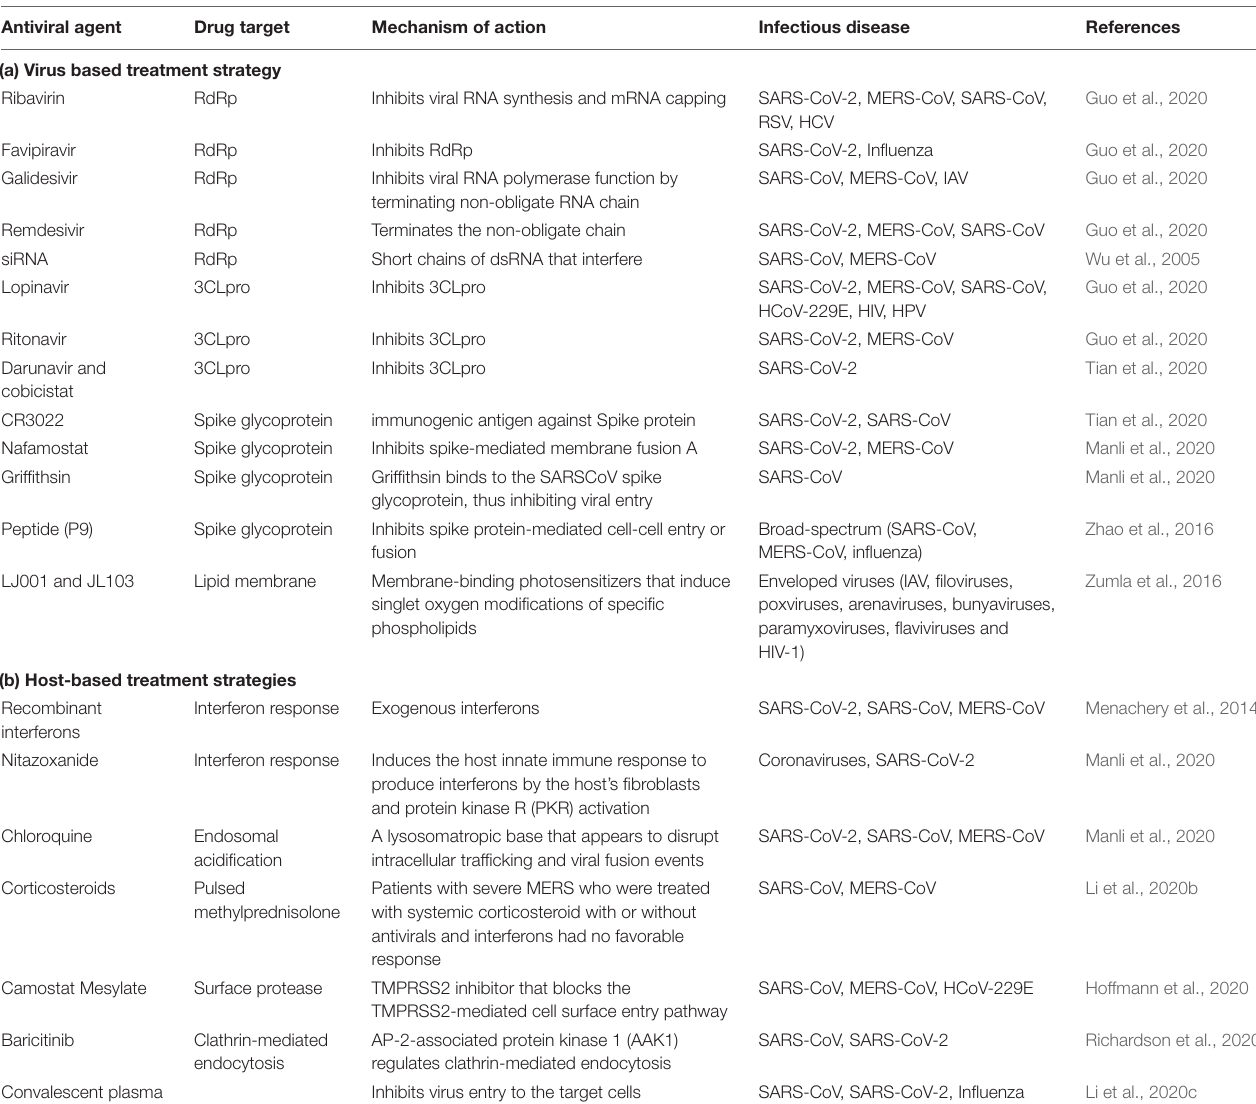
TABLE 1 | Possible therapeutic approaches against SARS-CoV-2